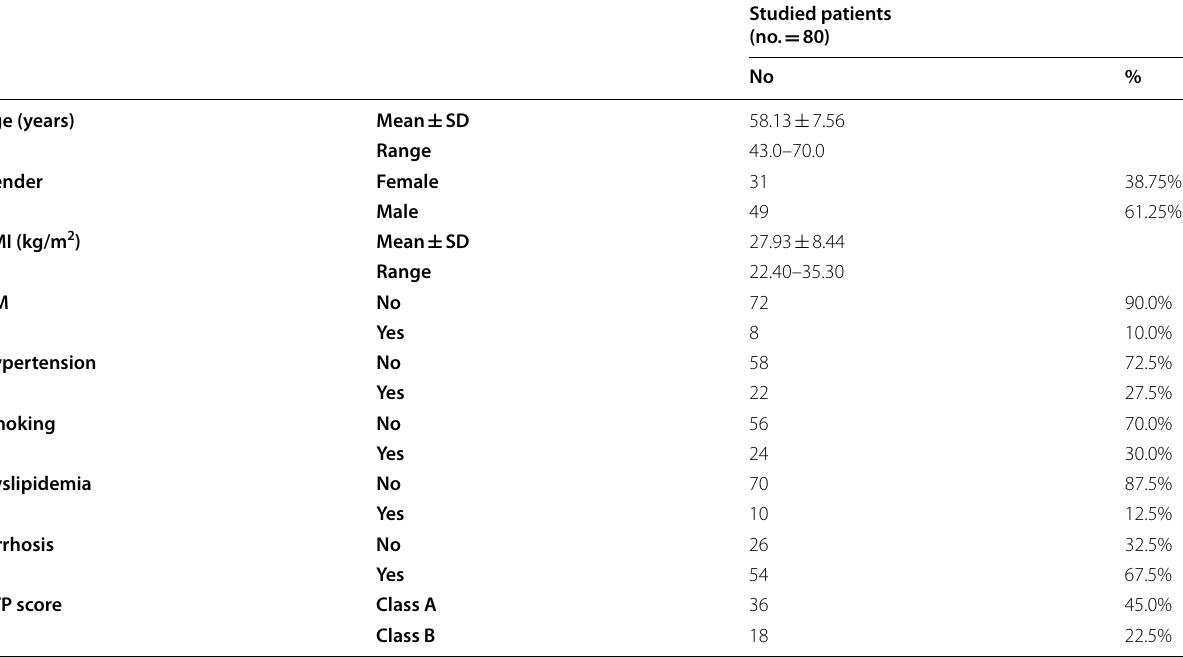
No. number, % percentage, SD Standard deviation, CTP Child-Turcotte-Pugh. The mean age in the studied cases was 58.13 70 years. Regarding gender, 49 (61.25%) patients were male, and 31 (38.75%) patients were female with male to female ratio 1.58:1. The mean BMI of patients